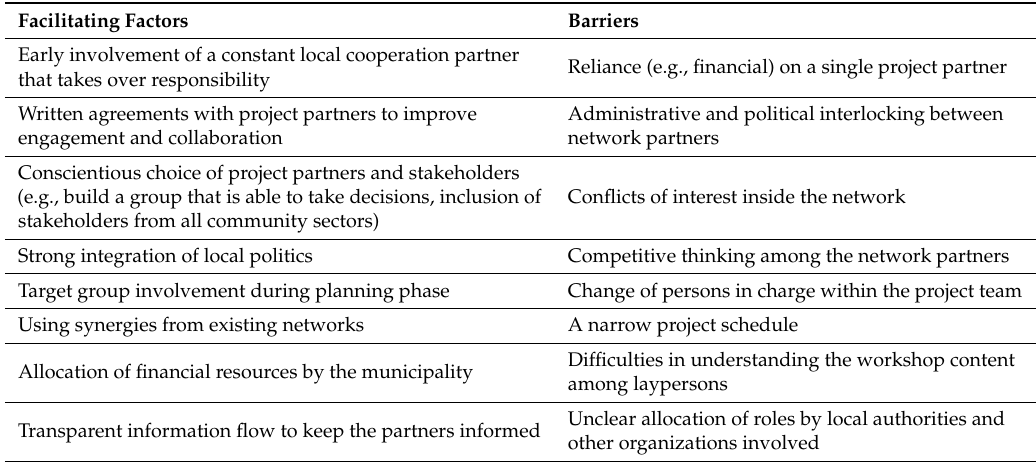
Table 3. Facilitating factors and barriers in the capacity building